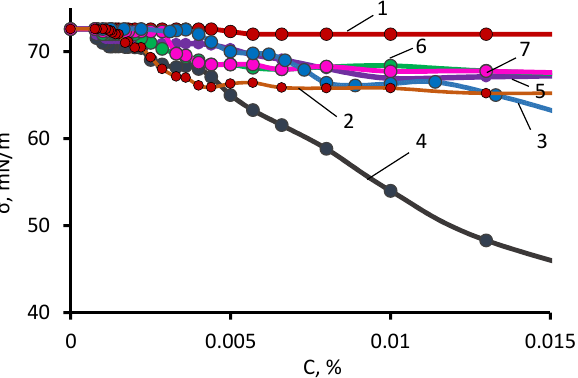
Figure 6. Isotherm curves of surface tension ( σ , mN/m) on concentration in water ( С , %) for PEO (1), AGM (2), PEOASiP (3), ASiP–AGM-10 (4), ASiP–AGM-50 (5), ASiP–AGM-80 (6) and ASiP– AGM-100 (7).